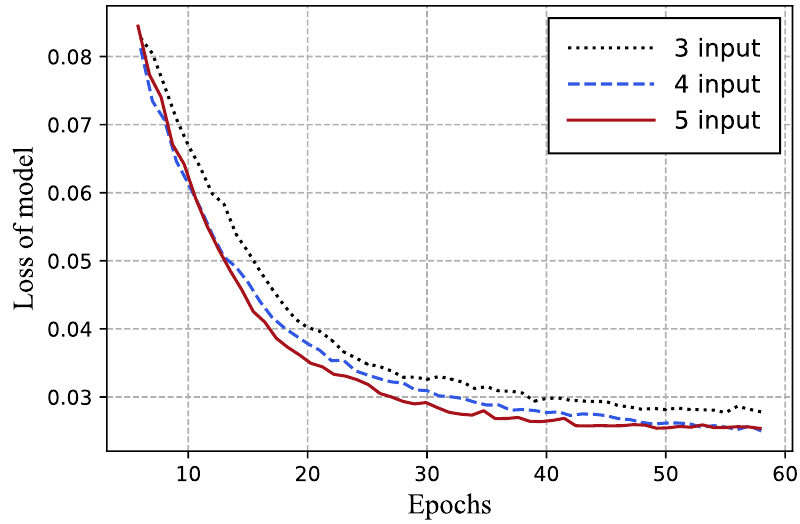
Figure 12. Change of model loss under different